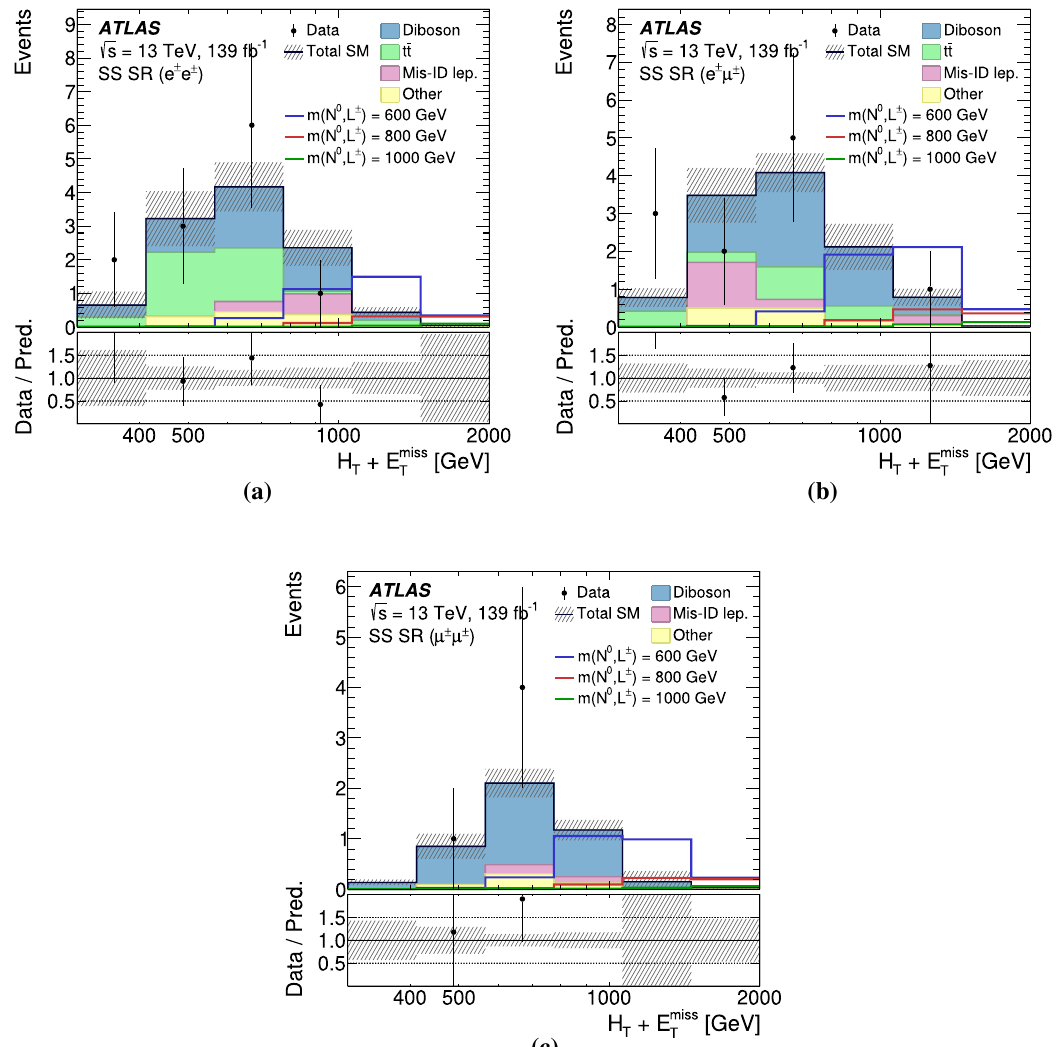
Fig. 4 Distributionsof H T + E miss all systematic uncertainties post-fit with the correlations between vari- insame-signsignalregions,namely T a theelectron–electronsignalregion, b theelectron–muonsignalregion, ous sources taken into account. Errors on data are statistical only. The lower panel shows the ratio of the observed data to the estimated SM and c the muon–muon signal region after the background-only fit background described in the text. The coloured lines correspond to signal samples withthe N 0 and L ± massstatedinthelegend.Thehatchedbandsinclude